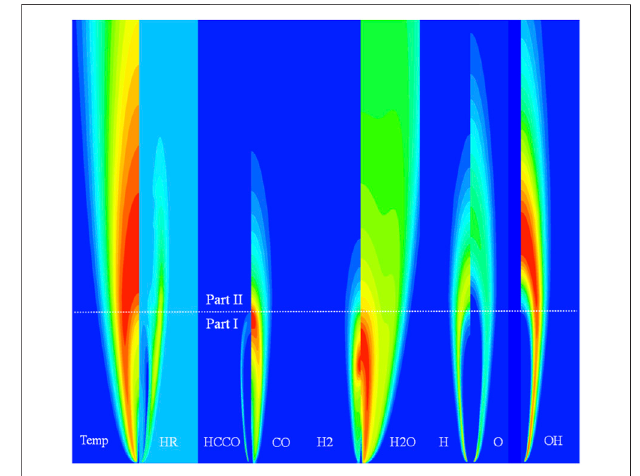
FIGURE12| Thestructureofthelaminarnon-premixedCH 4 jet fl ame( V F = 10 m/s) in an O 2 /CO 2 co fl ow. (Temp: temperature; HR: heat of